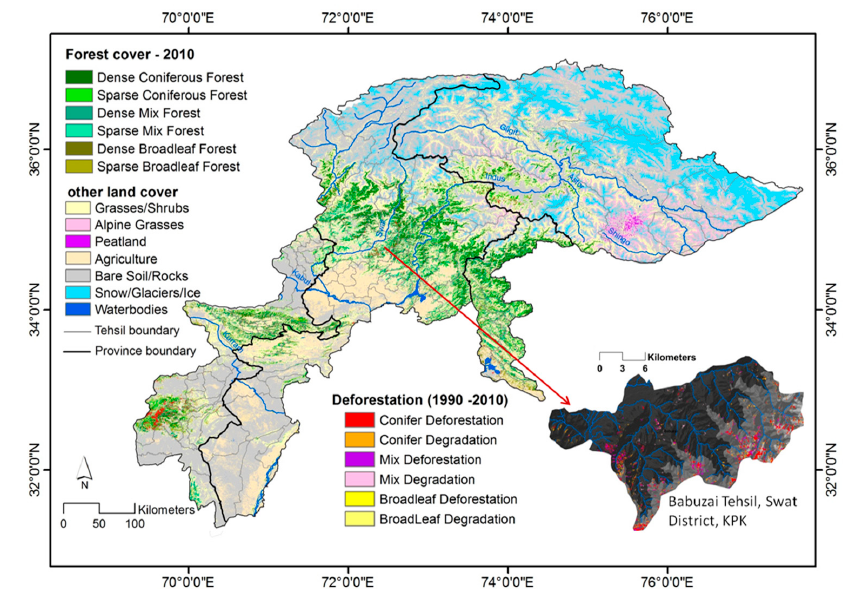
Figure 2. Land cover distribution and deforestation.